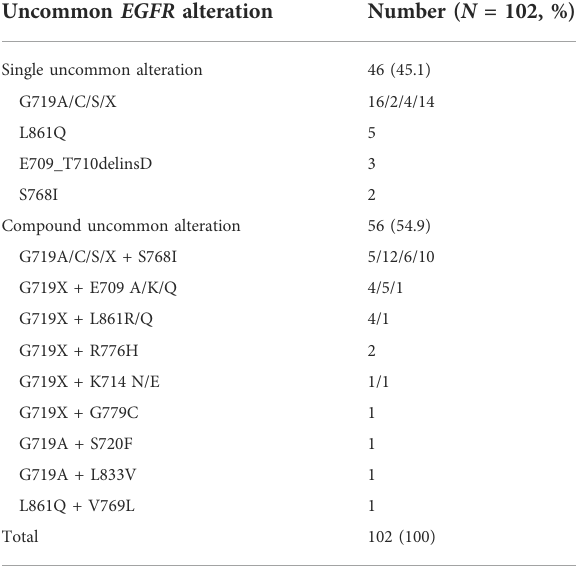
TABLE 2 Molecular subtypes of EGFR uncommon alterations.